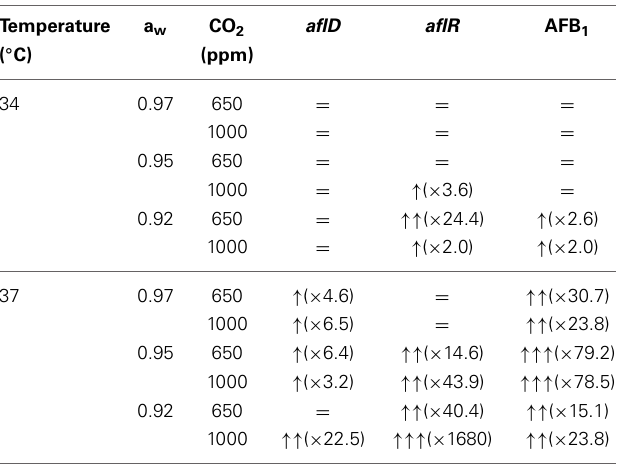
Table 3 | Summary of the impact that interactions between the three climate change variables have on relative expression of the structural and regulatory genes ( aflD , aflR ), and aflatoxin B 1 production (from Medina et al., in